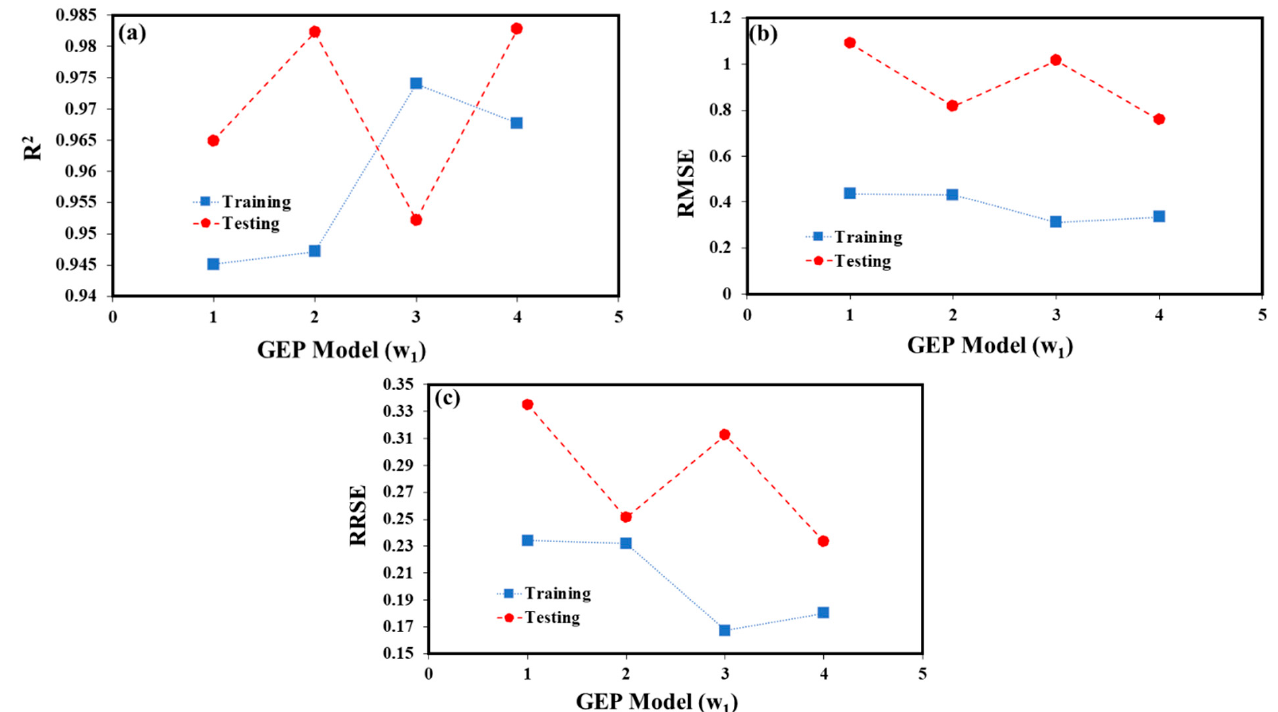
Figure 3. The comparison of the validation GEP (w1) model criteria ( a ) R 2 , ( b ) RMSE, and ( c ) RRSE values for the training and testing datasets.